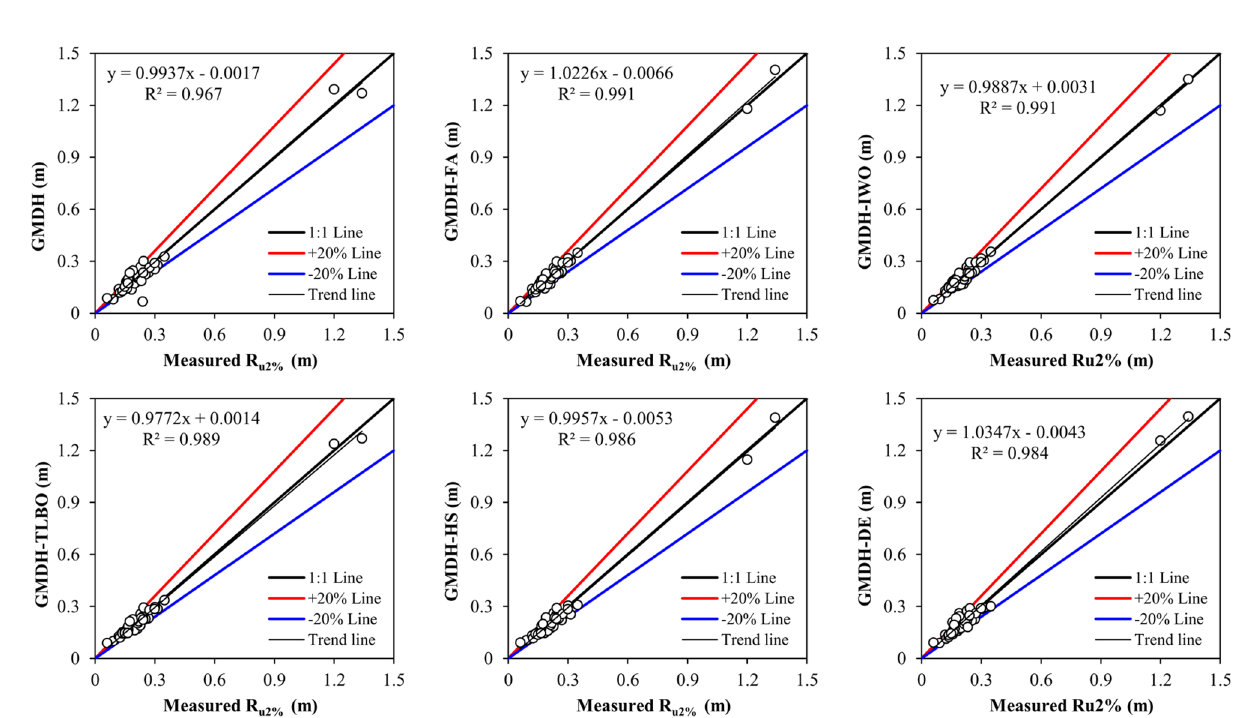
Figure 5. Scatter plots obtained for the testing